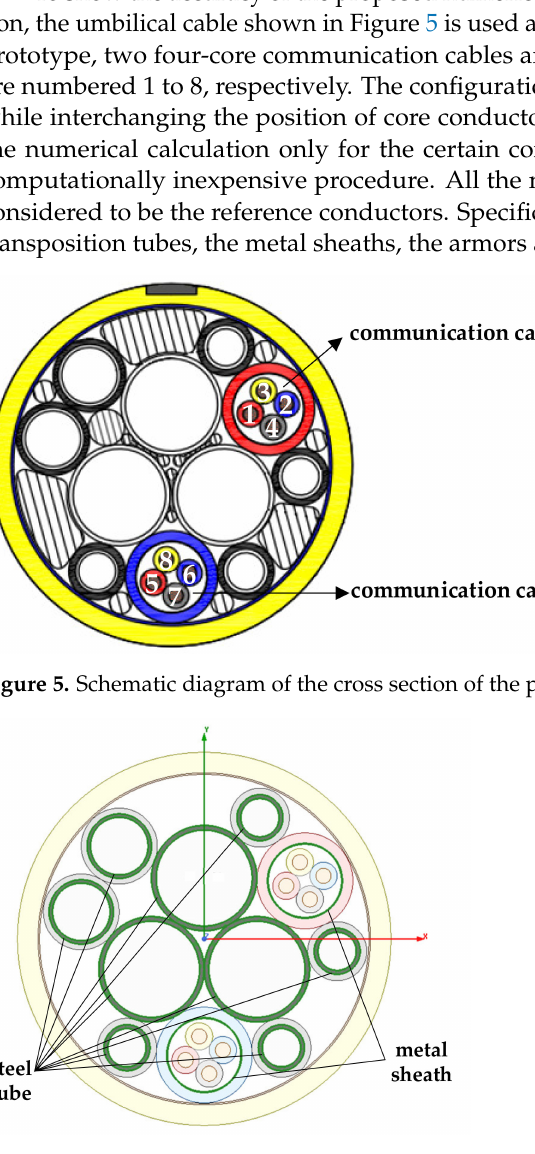
Figure 6. Reference conductors of the finite element